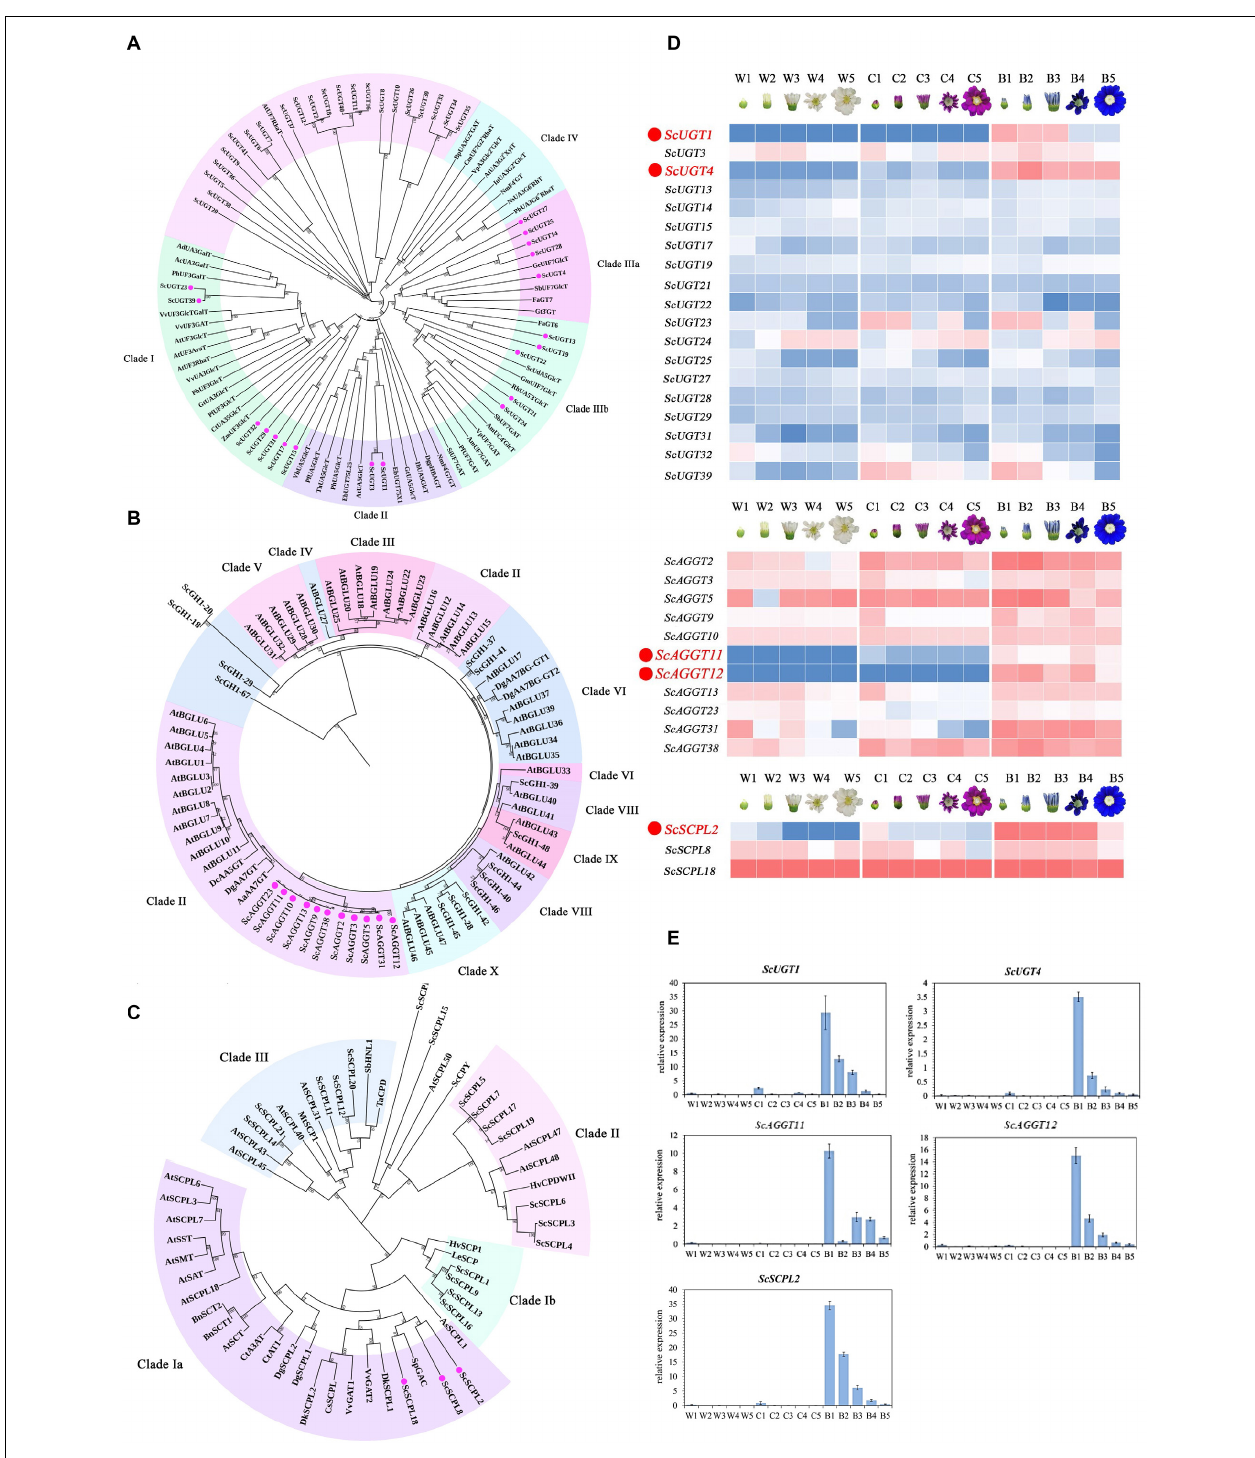
FIGURE 6 | Identification of ScUGTs/ScGH1s/ScSCPLs involved in polyacylated anthocyanin biosynthesis by phylogenetic analysis and gene expression pattern analysis. Amino acid sequences of ScUGTs (A) , ScGH1s (B) , ScSCPLs (C) , and all arabidopsis UGTs/BGLUs/SCPLs and some sequences from other plants were used to build three phylogenetic trees based on maximum likelihood. (D) Heatmap analysis based on the RT-PCR data was performed to screened out the candidate key genes ( ScUGTs/ScAGGTs/ScSCPLs ) encoding glycolyltransferase and acyltransferase that might be involved in the polyacylation modification of anthocyanins. (E) The expression profiles of ScUGT1 , ScUGT4 , ScAGGT11 , ScAGGT12 , and ScSCPL2 were analyzed by qRT-PCR. The data were the mean ± SD from three biological replicates.